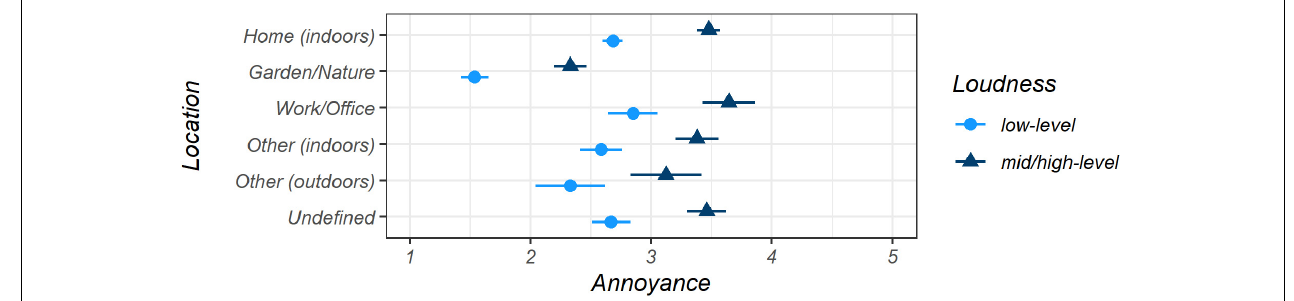
FIGURE 4 | Estimated marginal means for Annoyance for all Location categories, separated by binary Loudness levels, displayed with 95% confidence intervals, both determined by bootstrapping. Very pleasant = 1, very annoying = 5. Model Location